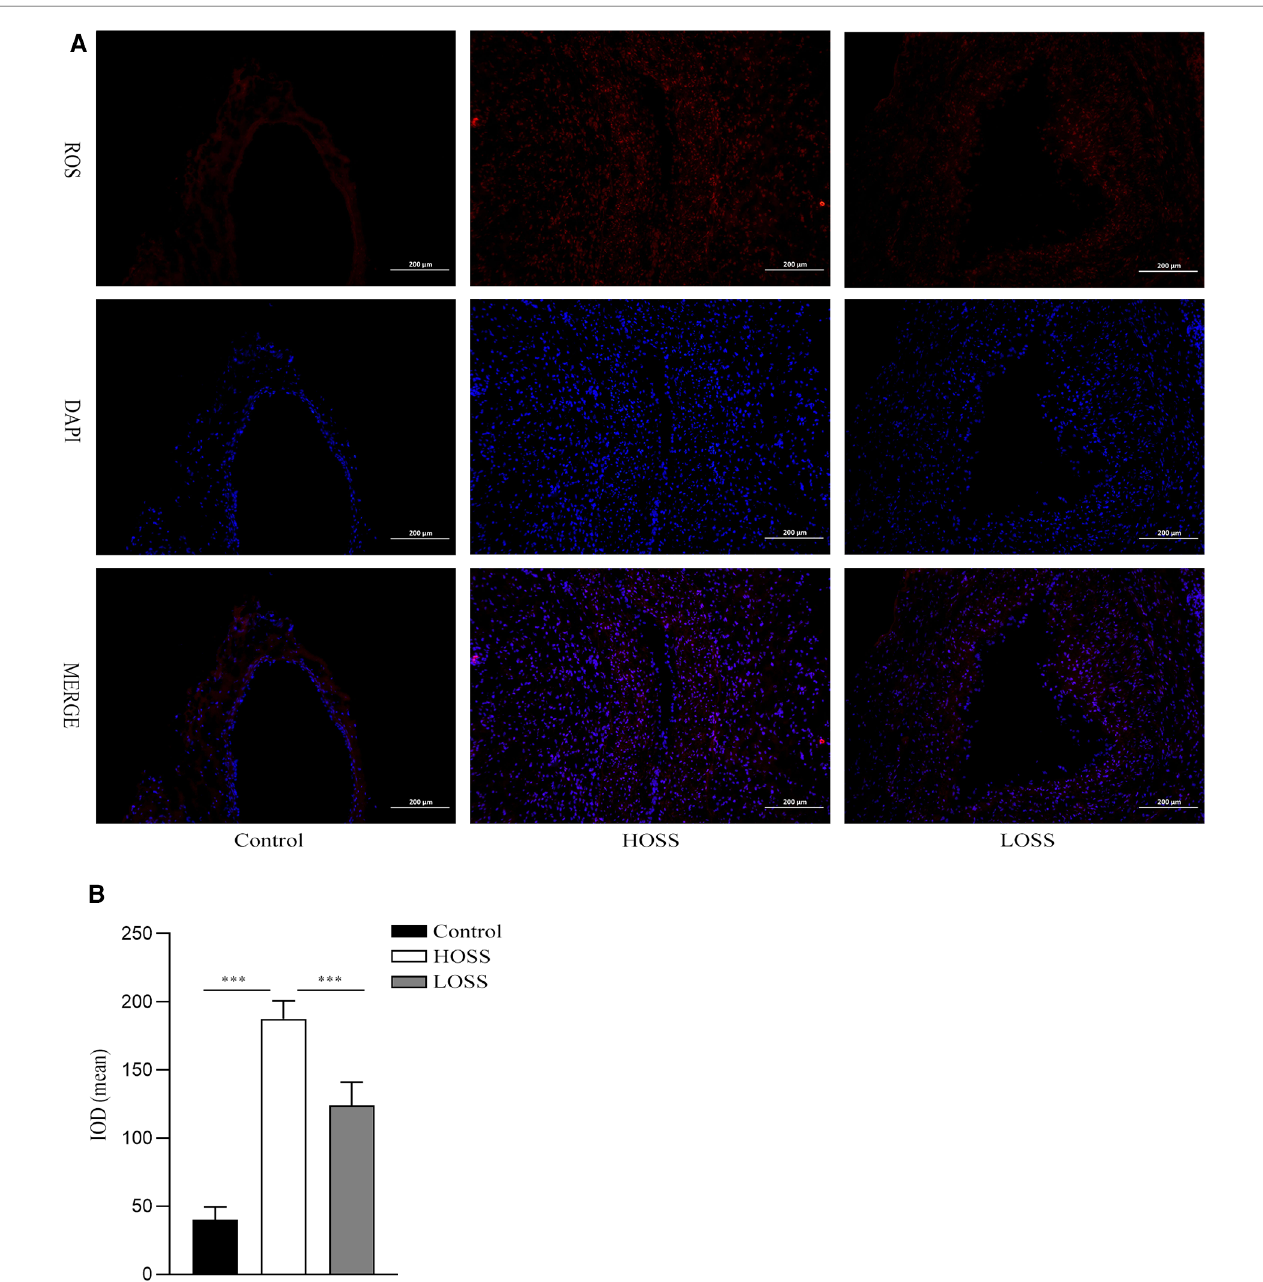
FIGURE 5 Oscillatory shear stress (OSS) upregulated reactive oxygen species (ROS) expression. ( A ) Immuno fl uorescence staining was used to measure the expression of ROS in the grafted veins. ROS (red) expression in grafted veins of different experimental groups was determined by immuno fl uorescence staining (magni fi cation,×100). DAPI (blue) was used for nuclear staining. ( B ) Statistical analysis showed that the ROS fl uorescence intensity was signi fi cantly increased in the high-OSS (HOSS) group and relatively diminished in the low-OSS (LOSS) group compared to that in the control group. Experiments were repeated in triplicate. *** P